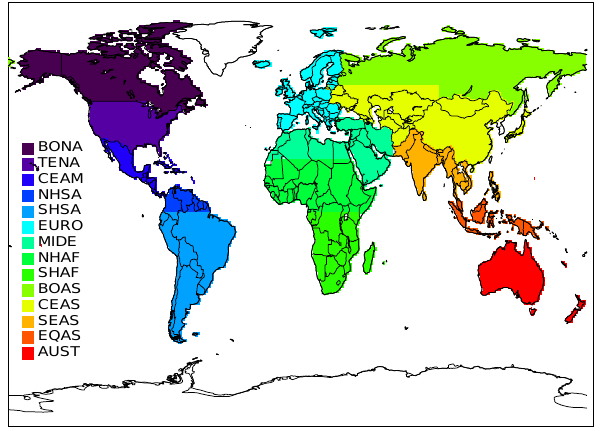
Fig. A3. Map of the 14 regions as defined in van der Werf et al. (2006) used in this study. BONA: Boreal North Amer- ica, TENA: Temperate North America, CEAM: Central Amer- ica, NHSA: Northern Hem. South America, SHSA: Southern Hem. South America, EURO: Europe, MIDE: Middle East, NHAF: Northern Hem. Africa, SHAF: Southern Hem. Africa, BOAS: Boreal Asia, CEAS: Central Asia, SEAS: Southeast Asia, EQAS: Equatorial Asia, AUST: